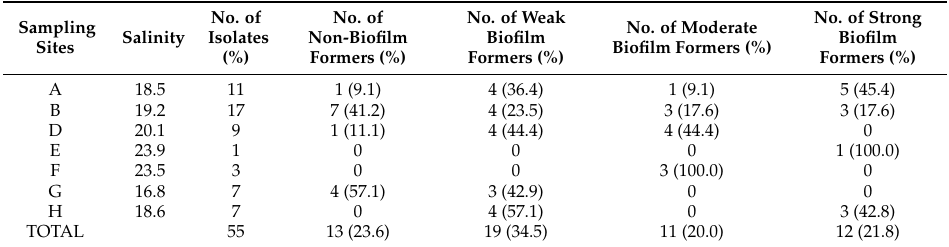
Table 3. Biofilm formation capabilities among 55 isolated K. pneumoniae from seven sampling sites with different salinity from the Matang mangrove estuary (Perak,